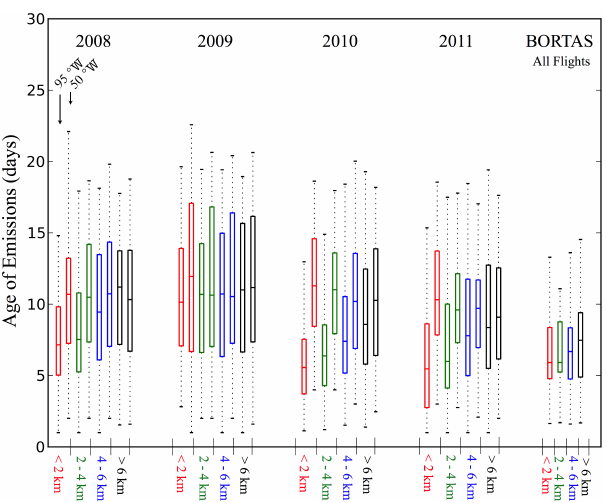
Figure 6. Box and whiskers plot showing the mean age of emis- sions for different altitudes ( < 2km, 2–4km, 4–6km, and > 6km) Fig. 6. Box and whiskers plot showing the mean age of emissions for different altitudes ( < 2 km, 2–4 km, at the longitudinal boundaries of the BORTAS-B domain (45 ◦ N– 4–6 km, and > 6 km) at the longitudinal boundaries of the BORTAS-B domain (45 ◦ N–60 ◦ N, 95 ◦ W–50 ◦ W) 60 ◦ N, 95 ◦ W–50 ◦ W) during July 2008, 2009, 2010, 2011, and for during July 2008, 2009, 2010, 2011, and for the model sampled along the BORTAS-B flights. Within the box, the upper, middle, and lower horizontal bars denote the first quartile, the median, and the third quartile. The the model sampled along the BORTAS-B flights. Within the box, fullrangeofdataisshownbythewhiskers. the upper, middle, and lower horizontal bars denote the first quar- tile, the median, and the third quartile. The full range of data is shown by the